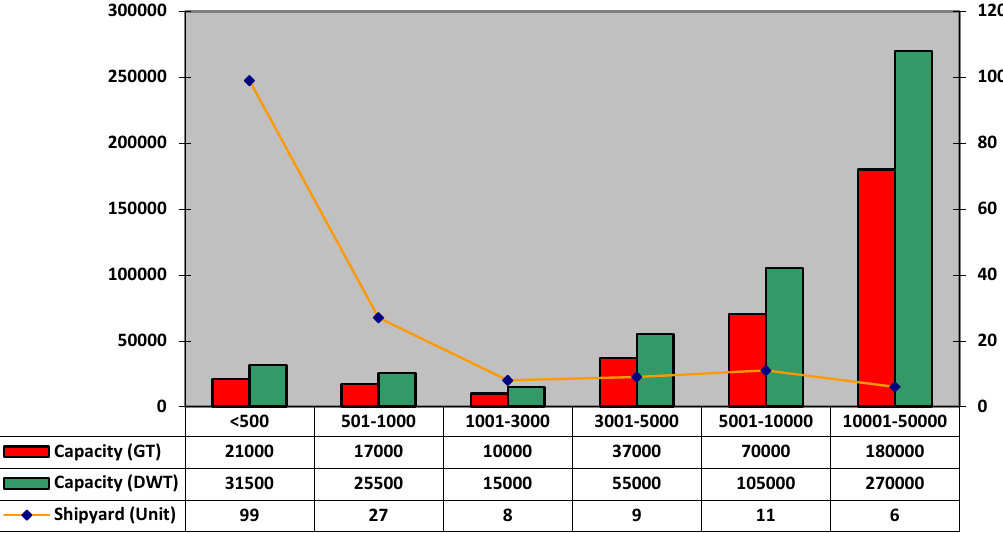
Fig. 1. Shipyard industry capacity Source: Indonesia Ministry of Industry